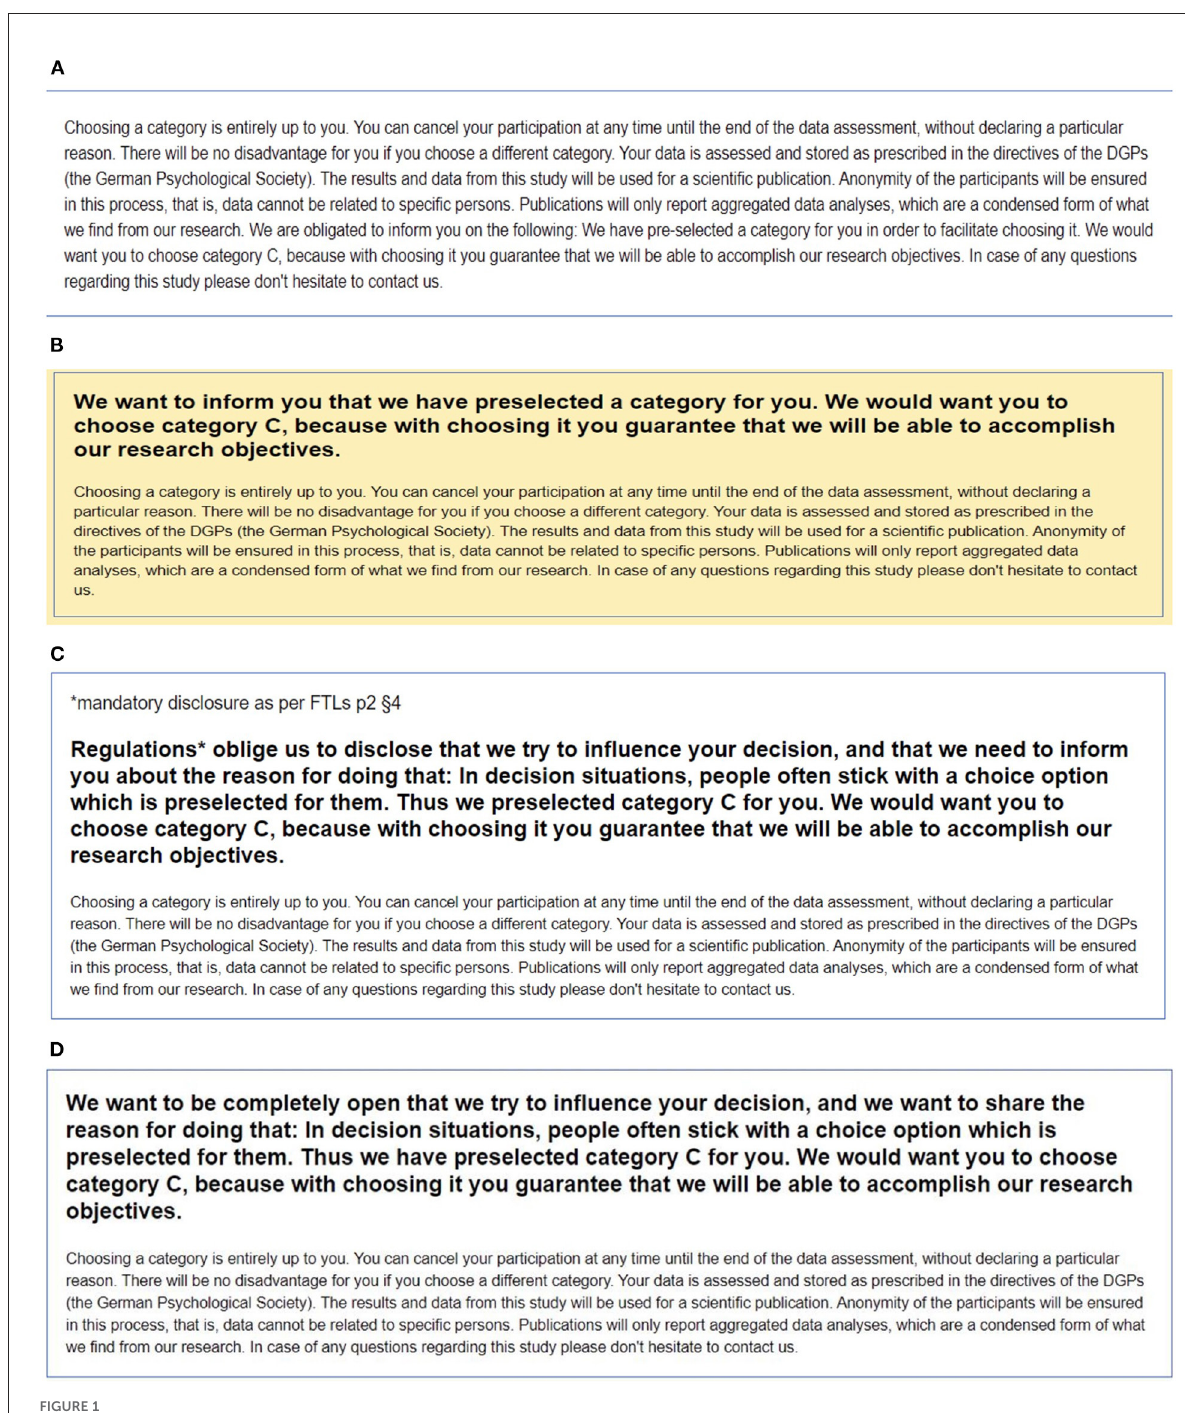
of defaulting in both studies, and we can move on to testing whether choices were affected by the respective transparency